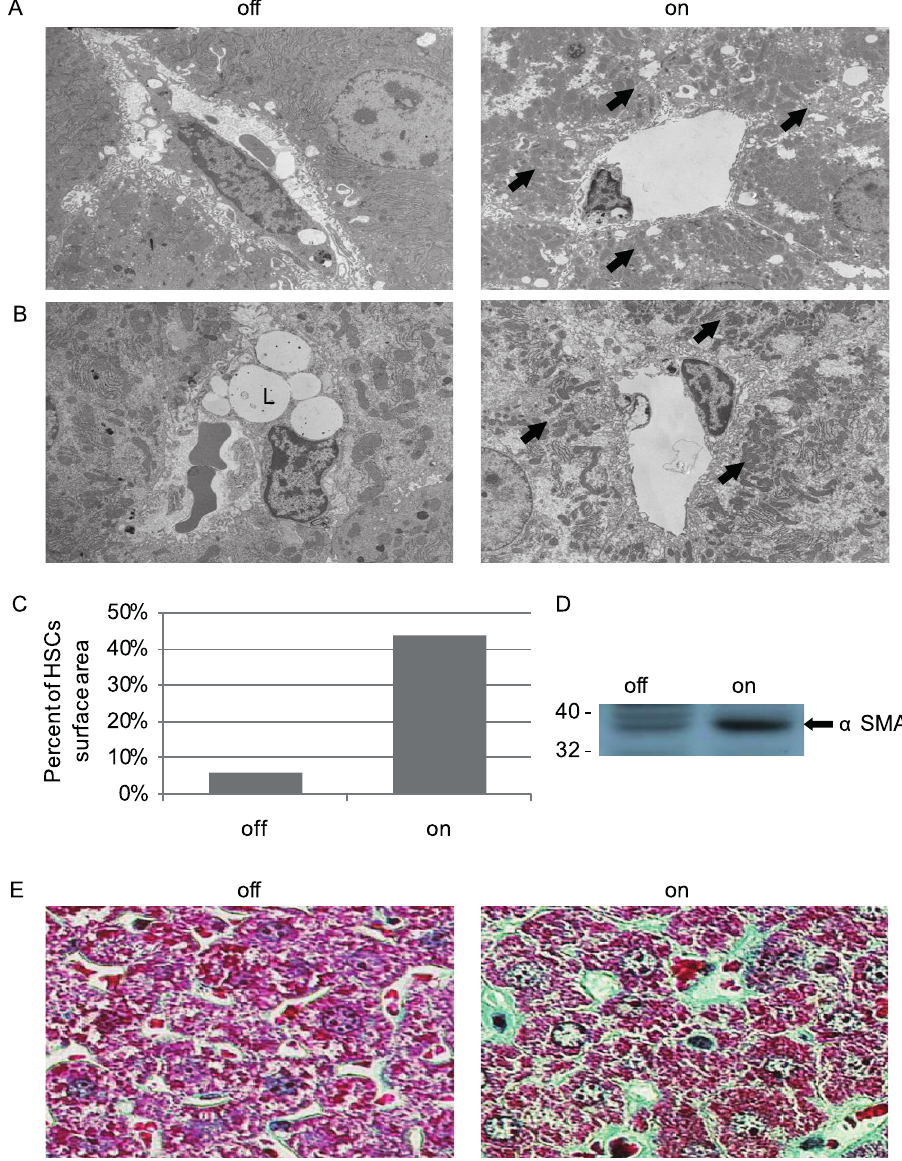
Figure 3. sVEGF-R1 expression in the adult liver causes activation of HSCs. (a) Scanning electron microscopy of sinusoids in ‘off’ (a control littermate) vs. switch ‘on’ liver for one month showing prominent HSCs surrounding sinusoids (arrows) (b) Scanning electron microscopy showing transformation of HSCs from lipid droplets (L) containing cells (‘off’) to myofibroblasts like cells (arrows). (c) Quantification of the surface area of HSCs. ‘off’-5.8%, ‘on’ (sVEGF-R1 expression for one month)-43.7%. (d) Western blot analysis with anti a -smooth muscle actin antibody performed on liver extracts (e) Goldner staining for collagen fibers (green) indicating perisinusoidal accumulation of extra-cellular matrix.